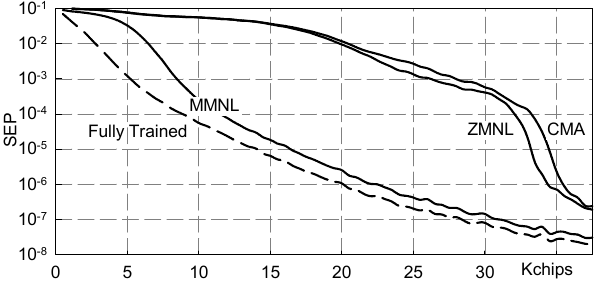
Figure 9. SEP vs. transmitted chips: channel (20), NSR = 20 dB.